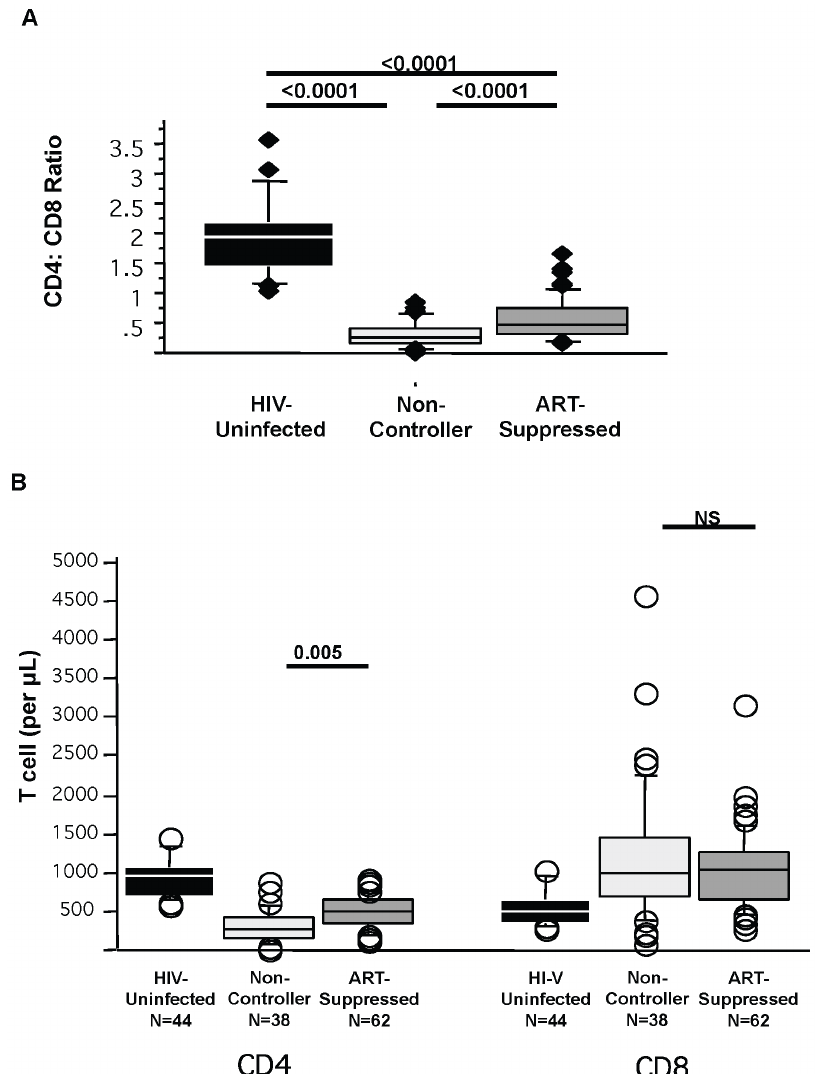
Figure 2. CD4:CD8 T cell ratio. CD4 + and CD8 + T cell counts were enumerated among different patient groups. Non-controllers are HIV infected individuals with ongoing viral replication. ART-suppressed are HIV-infected individuals with undetectable peripheral viral loads on antiretroviral therapy. HIV-uninfected individuals are controls. CD4:CD8 T cell ratios (A) and individual CD4 and CD8 T cell counts (B) are shown.